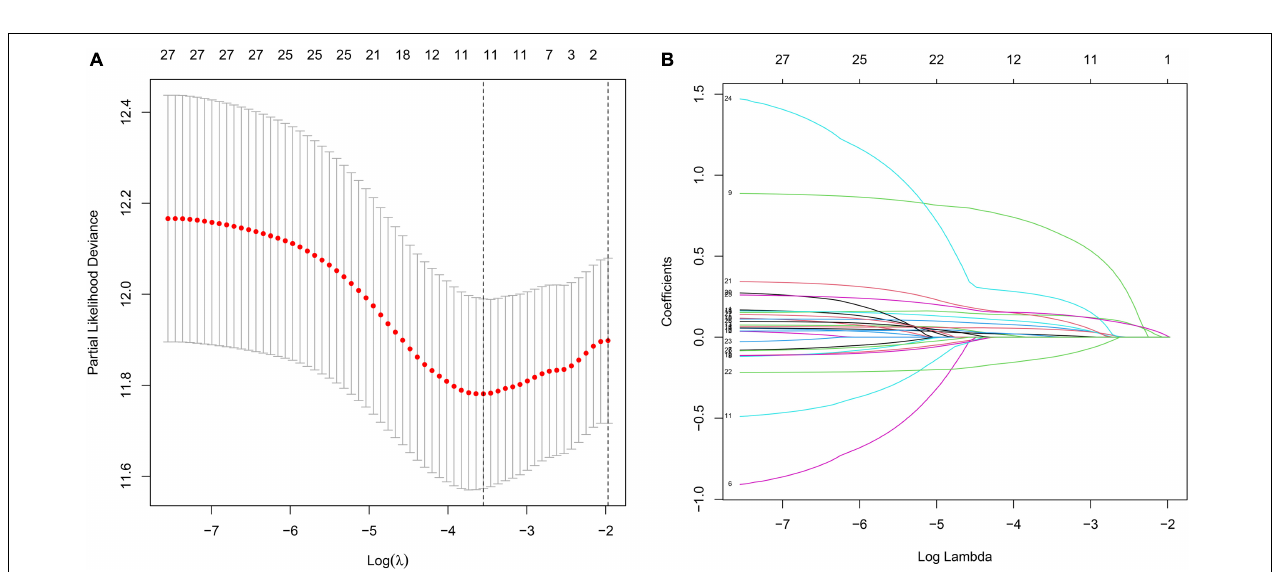
FIGURE 4 | The construction of inflammation-related gene signature for the prediction of prognosis in GC. (A) Least absolute shrinkage and selection operator (LASSO) regression. (B) LASSO coefficient profiles of 11 inflammation-related genes.